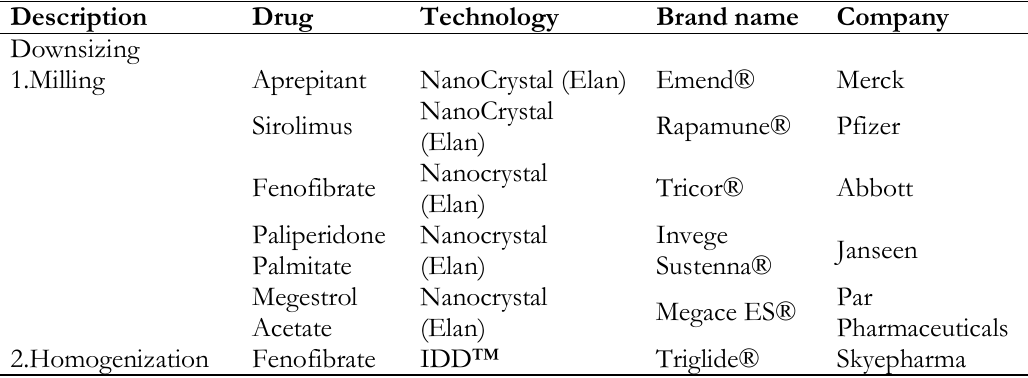
Table II. List of nano/ micro particle based drugs that are commercialized Description